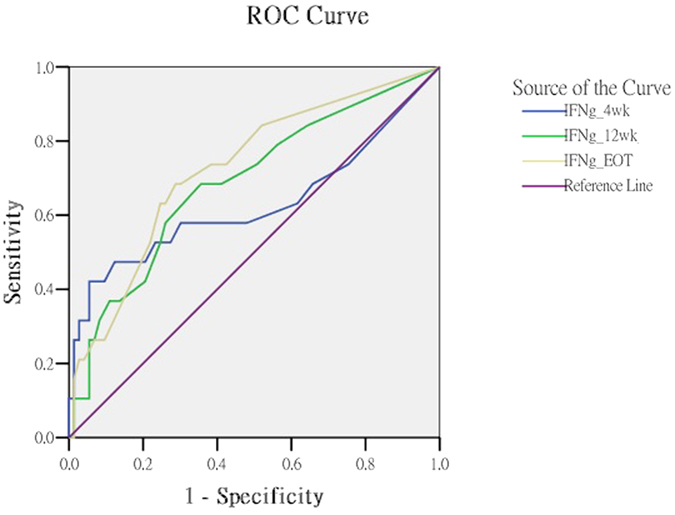
ROC curve analysis.